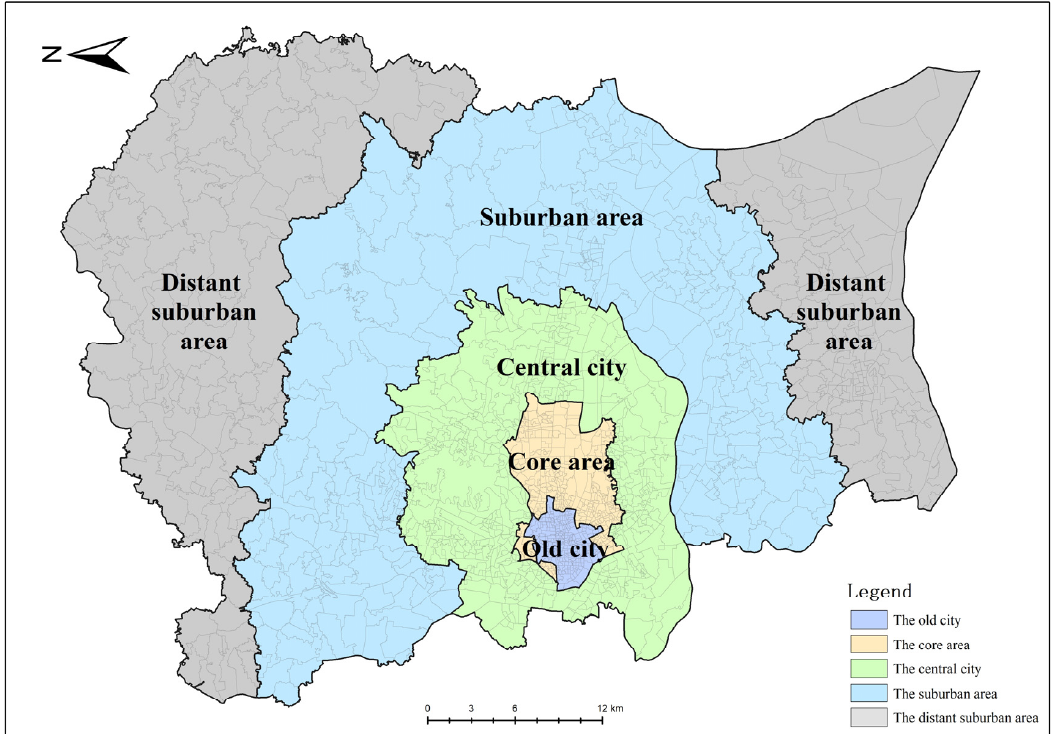
Figure 2. Schematic diagram of the regional division of the study area.